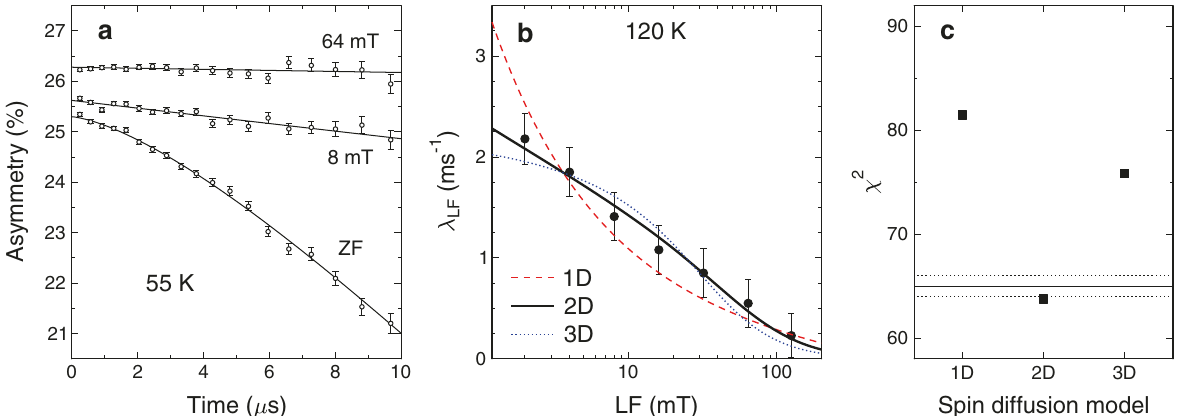
Fig. 2 Muon spin relaxation. a LF relaxation for two different fi elds at 55 K, with the ZF relaxation shown for comparison. Error bars indicate standard errors de fi ned by the counting statistics. b LF dependence of the relaxation rate at 120 K with fi ts to 1D, 2D, and 3D spinon diffusion models. Error bars indicate standard errors of the fi t parameters. c Quality of fi t, as described by the χ 2 parameter for global analysis of the set of λ LF values measured at 13 temperatures between 6 and 180 K, comparing different diffusion models. The expected value of χ 2 for a good model fi t is the number of degrees of freedom N D = 65, de fi ned as the difference between the number of data points (91) and the number of free parameters in the fi t (two for each temperature). N D is shown here as the solid line, with dotted lines indicating the expected χ 2 distribution width. From this analysis, we conclude that the 2D model is fully consistent with the data over the full temperature range, whereas the 1D and 3D models are